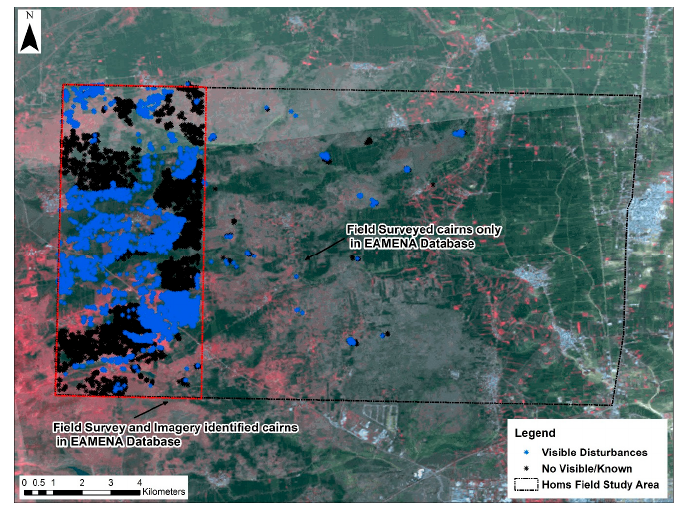
Figure 14. Distribution of disturbed cairns across the study area. Cairns are plotted against a multispectral Landsat 7 image (14 January 2000) processed in Erdas to show landcover. The area marked in red represents the area of cairns identified from satellite imagery, and not visited in the field, which have currently been assessed and recorded in the EAMENA database. Data entry for the cairns identified to the east of this sample area is currently on-going.